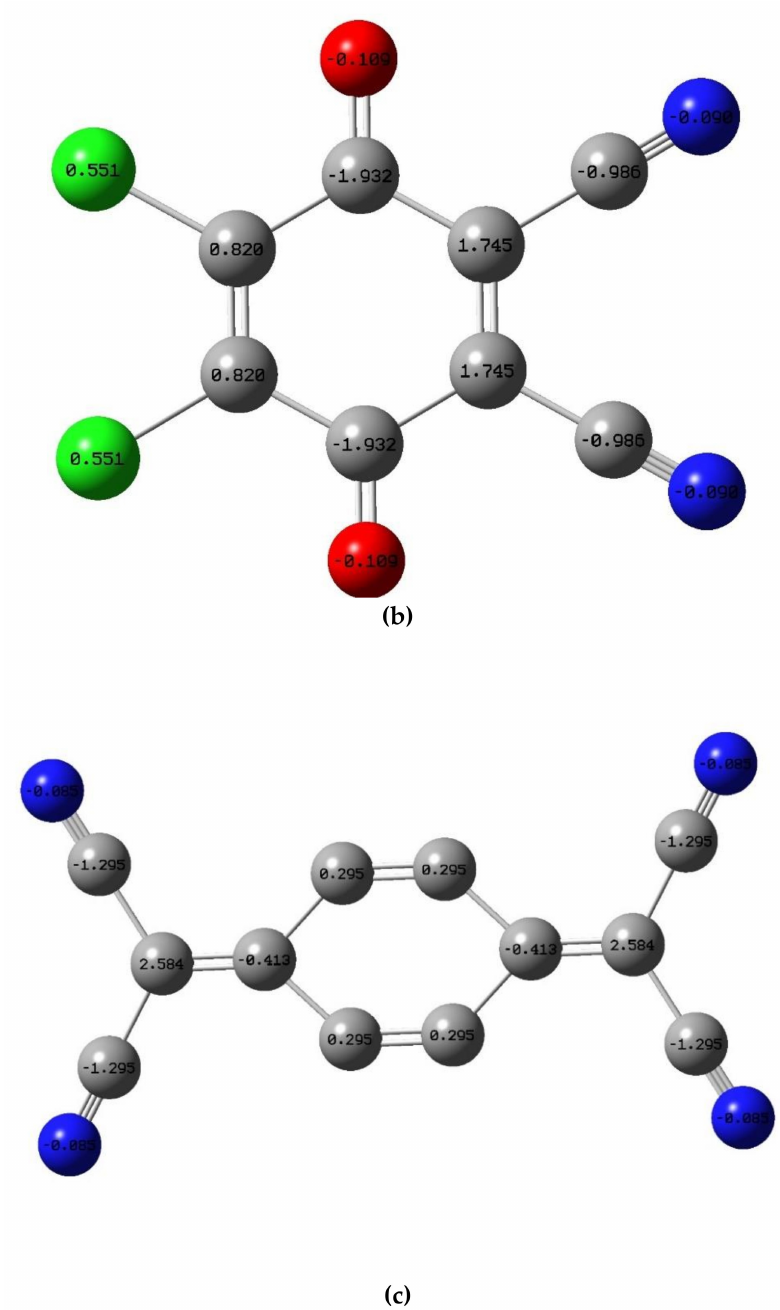
Figure 8. Mulliken atomic charges of ( a ) Quinine, ( b ) DDQ and ( c ) TNCQ. Conversely, a decrease of 0.0049 Å and 0.0048Å in the bond length of C(30)-O(31)